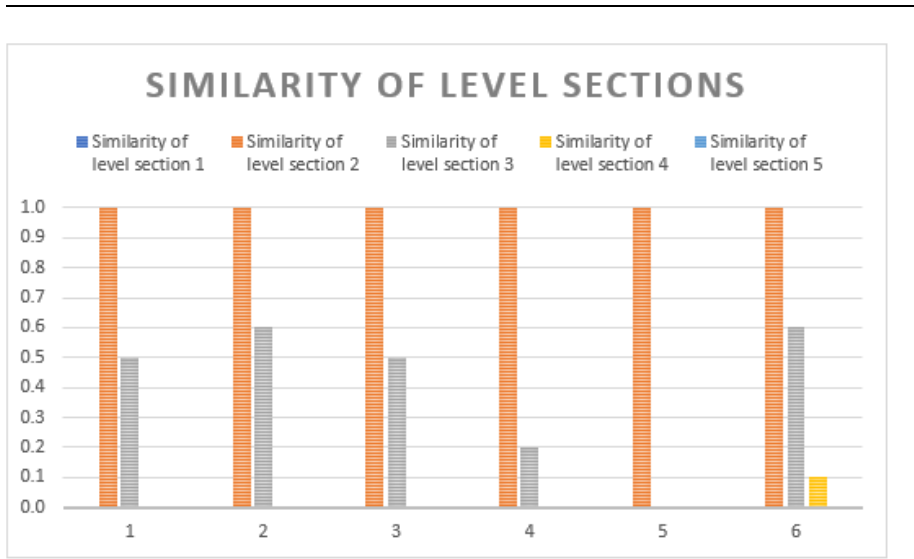
Figure 7. Similarity of level sections in Table